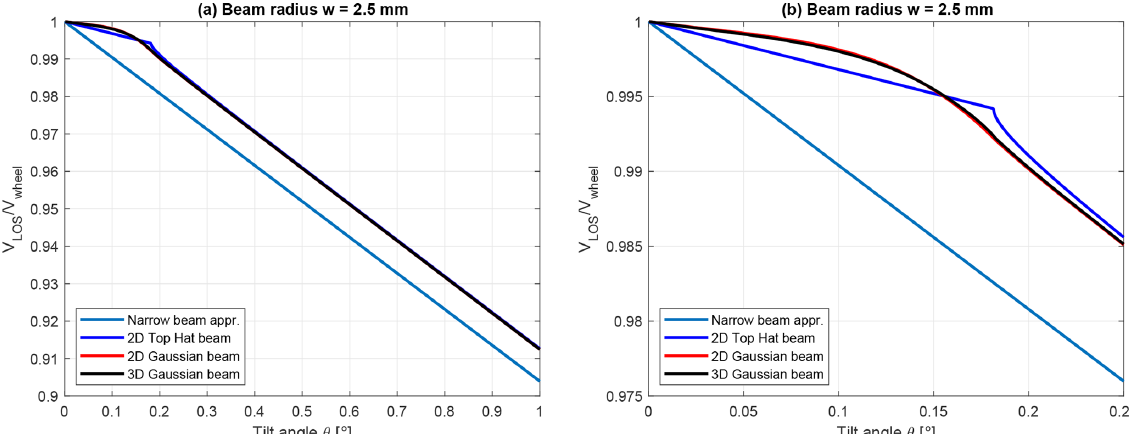
Figure 5. Comparison of the different models evaluated for tilt angles from 0 to 1 ◦ (a) and (b) a close-up focusing on the shallow angles where only a part of the beam touches the wheel. For the chosen beam radius, θ 1 = 0.18 ◦ .